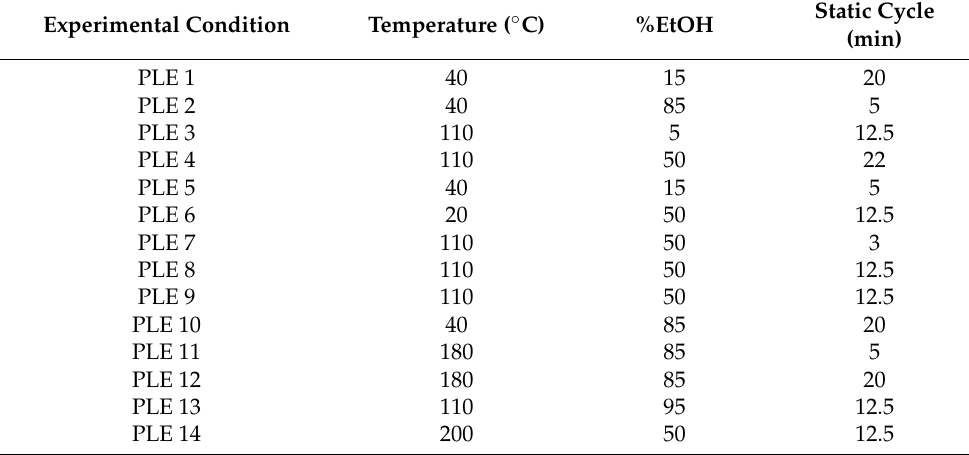
Table 1. Central composite model 2 3 . Values of independent factors. Experimental